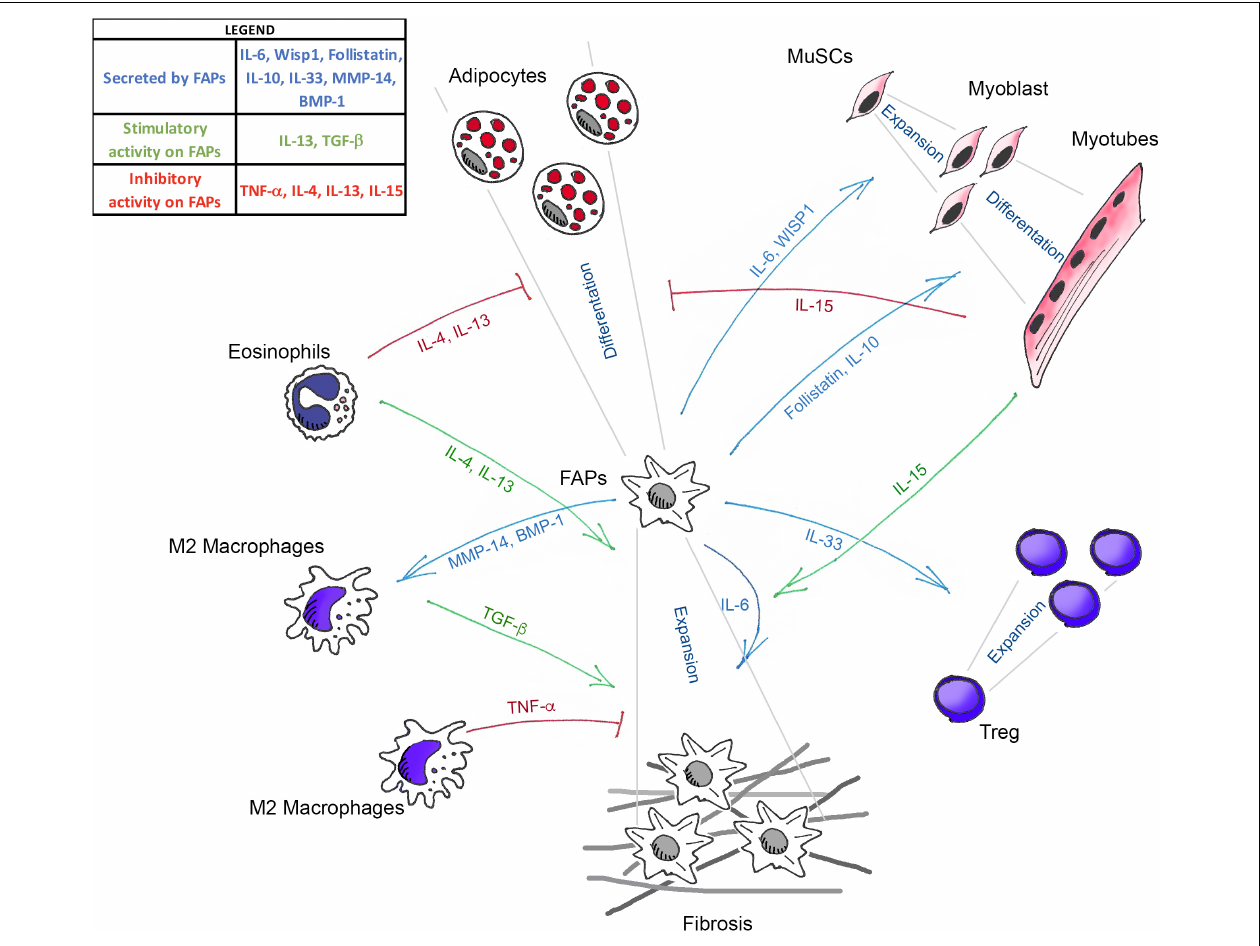
FIGURE 1 | Schematic illustration showing the known mediators that govern the interaction between FAPs, muscle stem cells (MuSCs), and the different immune cells in skeletal muscle homeostasis. Green arrows (TGF- β , IL-13, IL-4, and IL-15) indicate the molecules that positively regulate FAPs expansion. Blue arrows (IL-33, IL-6, Follistatin, IL-10, WISP1, MMP-14, and BMP-1) represent the molecules secreted by FAPs that act on the different cell targets. Red lines (TNF- α , IL-4, IL-13, and IL-15) show the factors that inhibit the fibro-adipogenic differentiation of